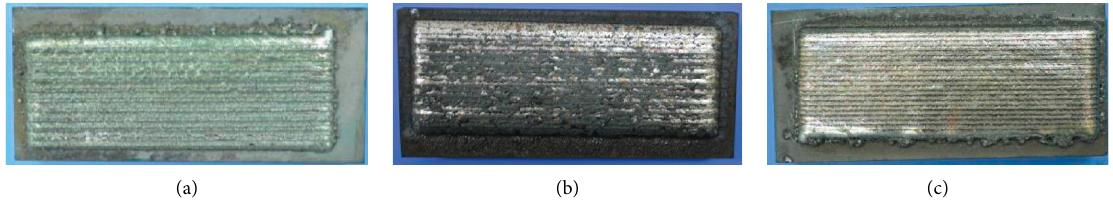
Figure 5: Macromorphology variation of the laser forming samples. (a) Sample without rosin and a gas curtain. (b) Sample with rosin but without a gas curtain. (c) Sample with rosin and a gas curtain.